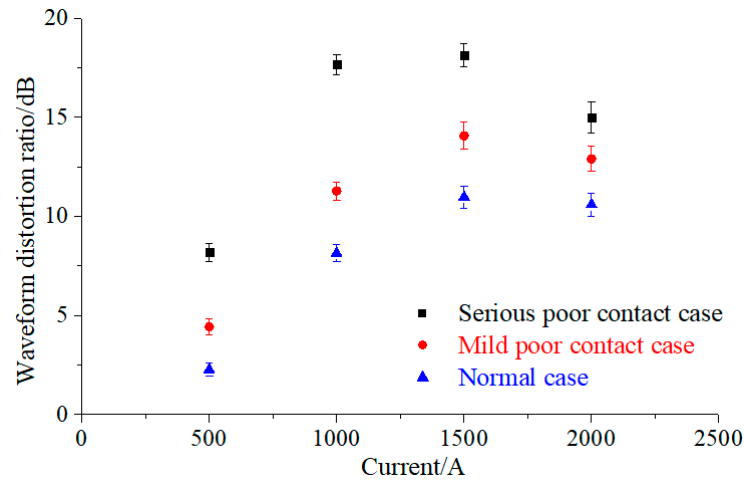
Figure 15. Comparison of waveform distortion ratio under different case.